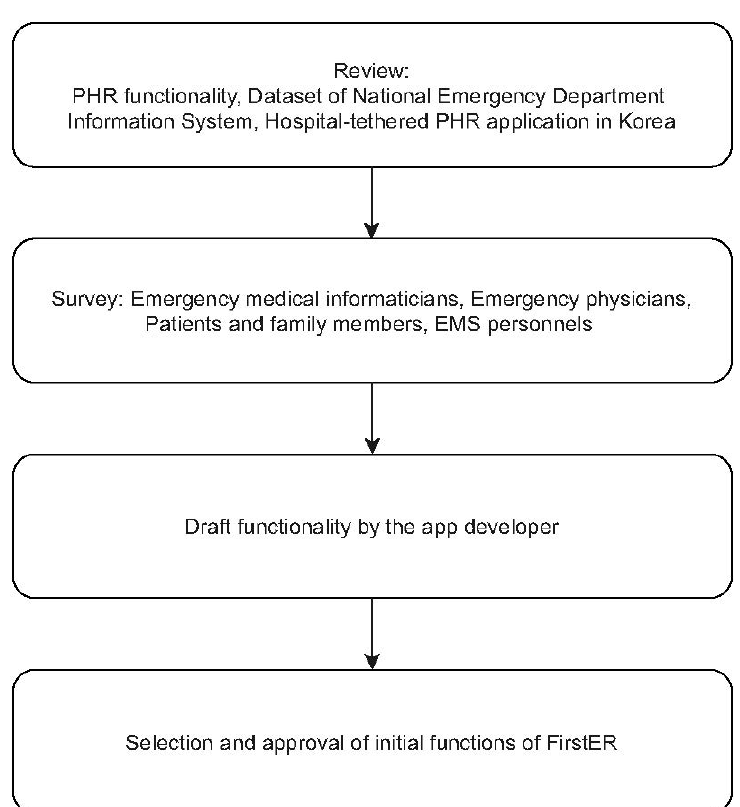
Figure 1. Process overview for mPHR for emergency departments (PHR: personal health record, EMS: emergency medical service, mPHR: mobile PHR).